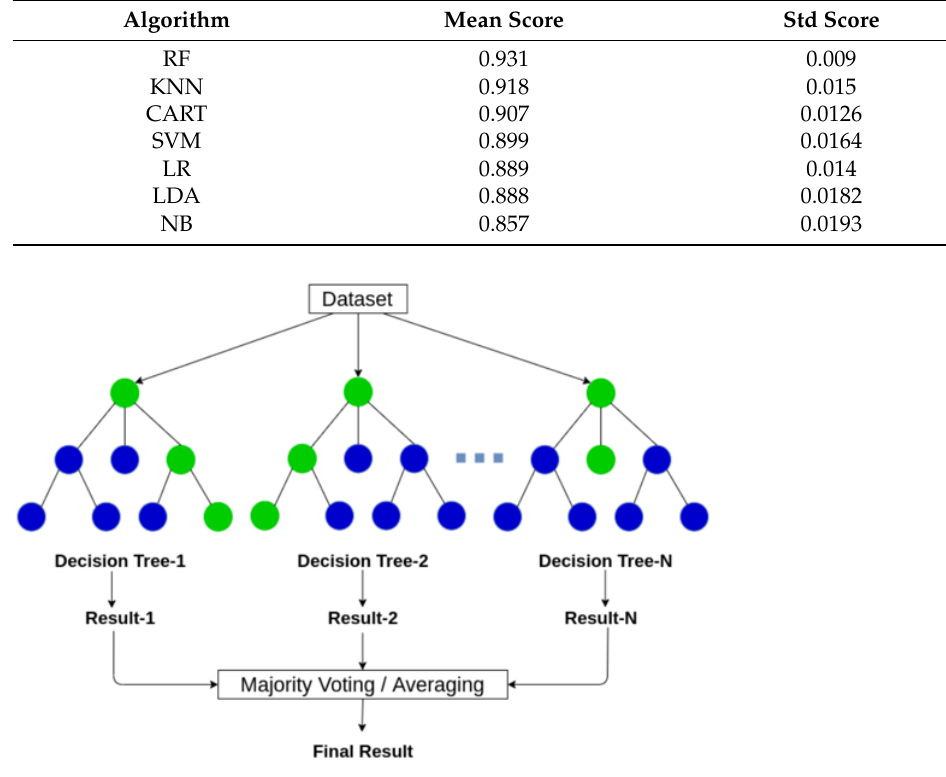
Figure 7. RF structure [37].